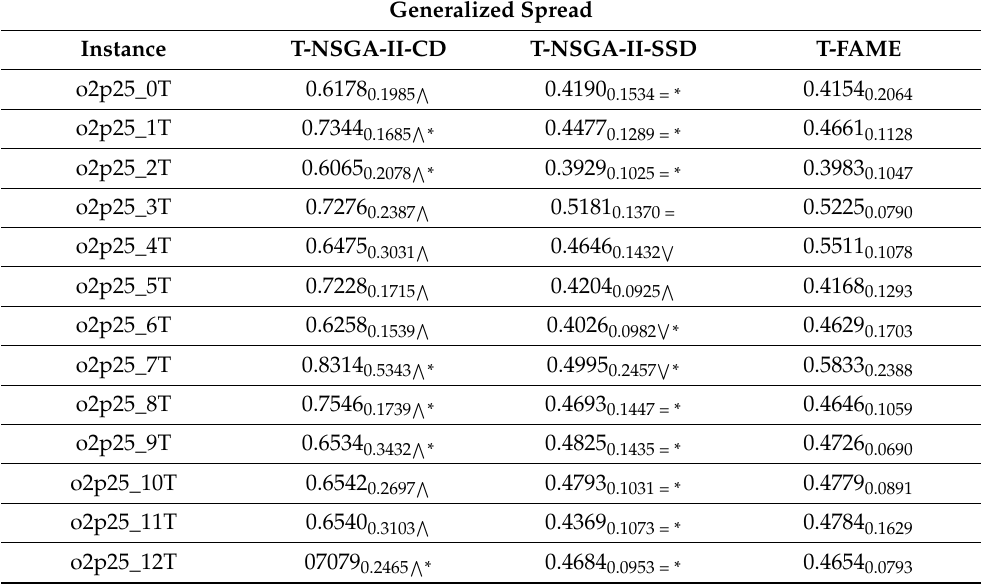
Table 11. Results with the generalized spread